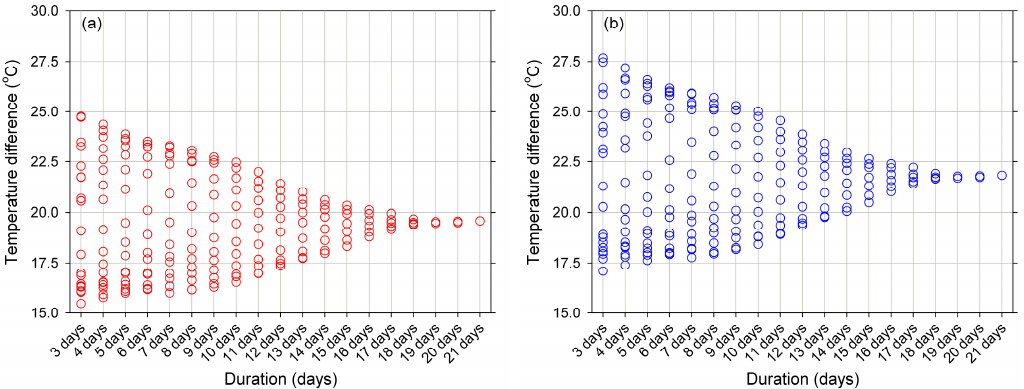
Figure 8. Average ( a ) surface and ( b ) air temperature differences between inside and outside environments for different analysis periods.